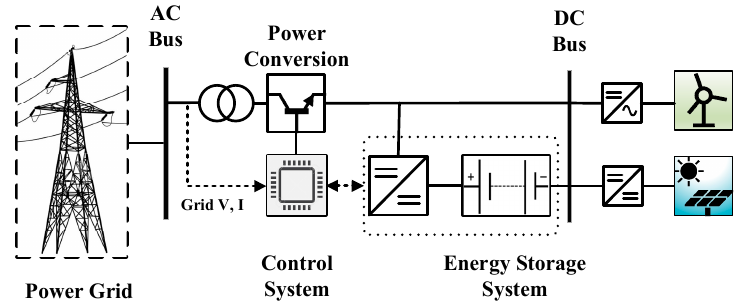
Figure 1. Conceptual block diagram of a virtual synchronous machine (VISMA).